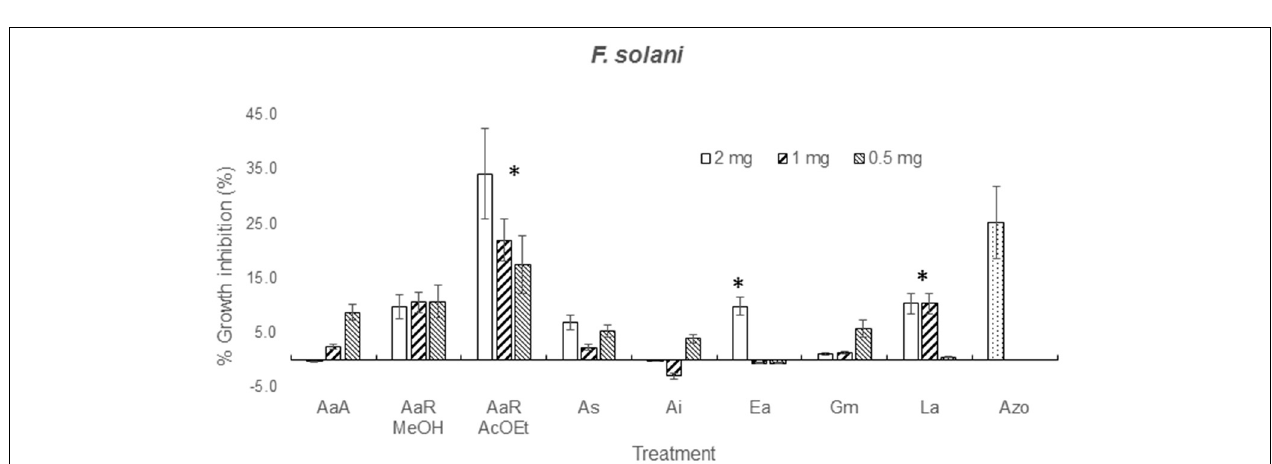
FIGURE 2 | Zone of inhibition (%) due to methanol extracts of aerial part (AaA) and roots (AaR MeOH and AaR AcOEt) of A. aurantium , aerial parts of A. subviscida (As), A. integrifolium (Ai), E. acutifolia (Ea), G. mexicanum (Gm), and L. achyranthifolia (La) at different